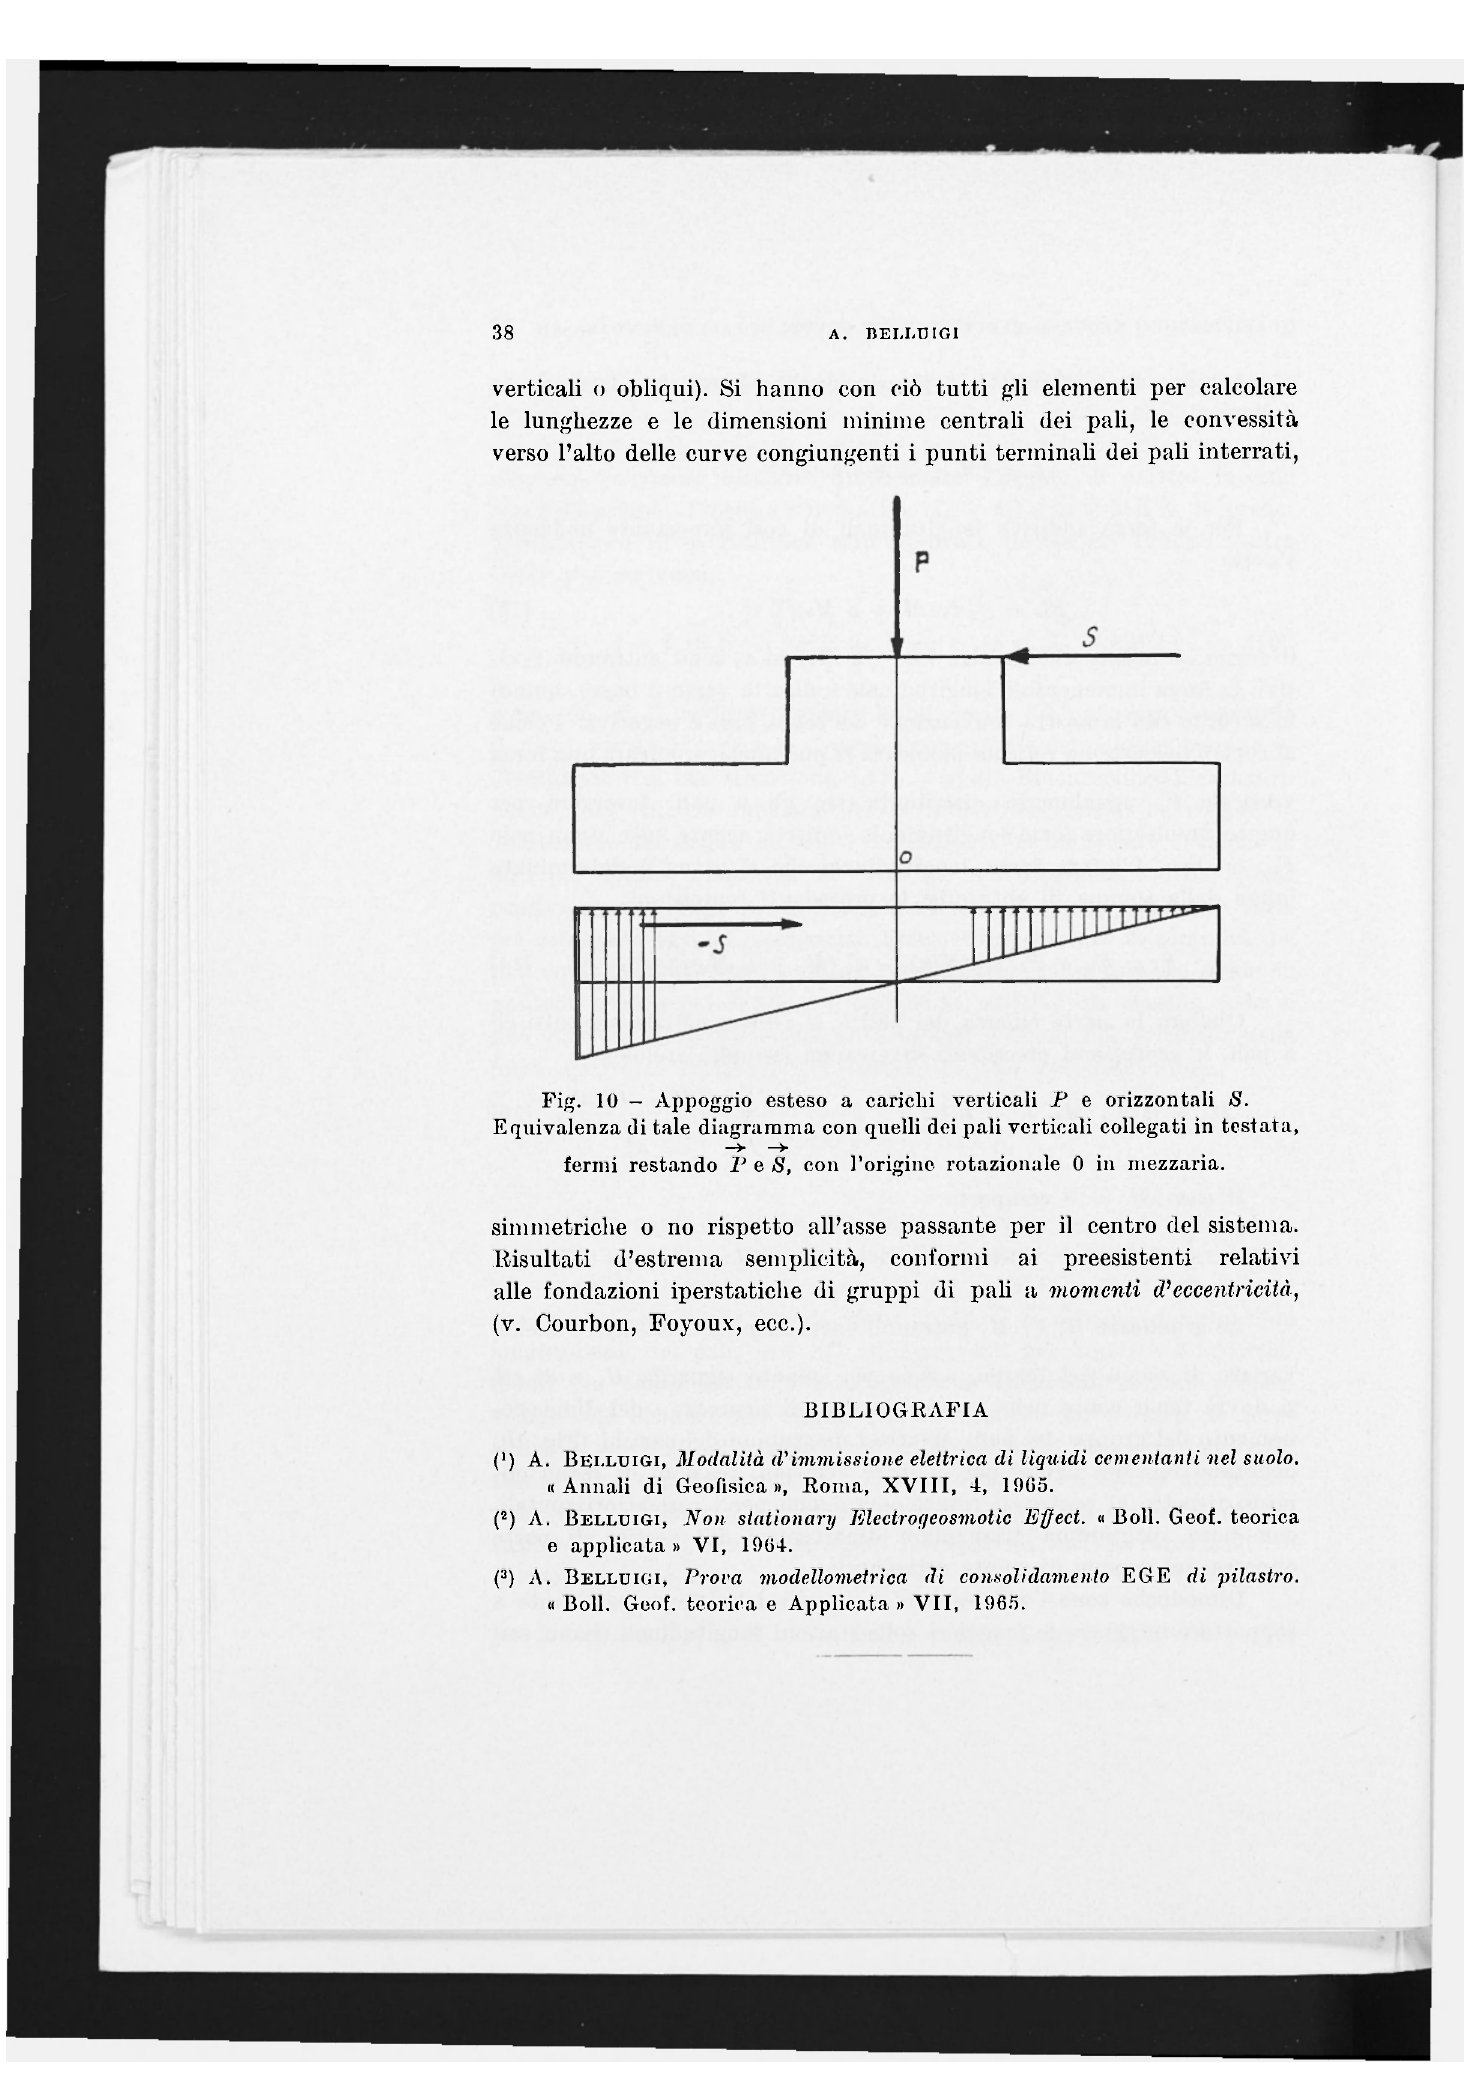
Fig. 10 — Appoggio esteso a carichi verticali P e orizzontali